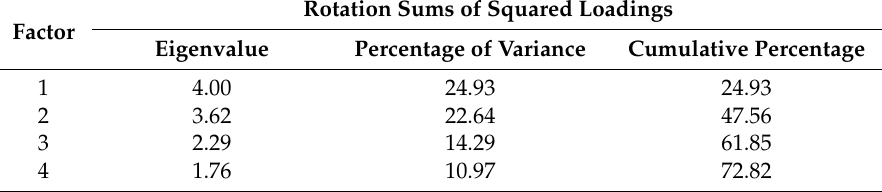
Table 4. The total variance explained.